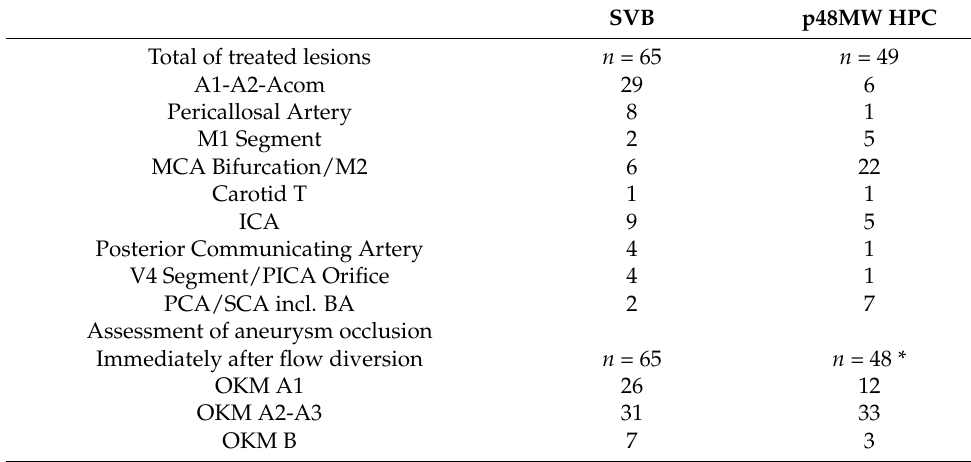
Table 2. Overview of the treated